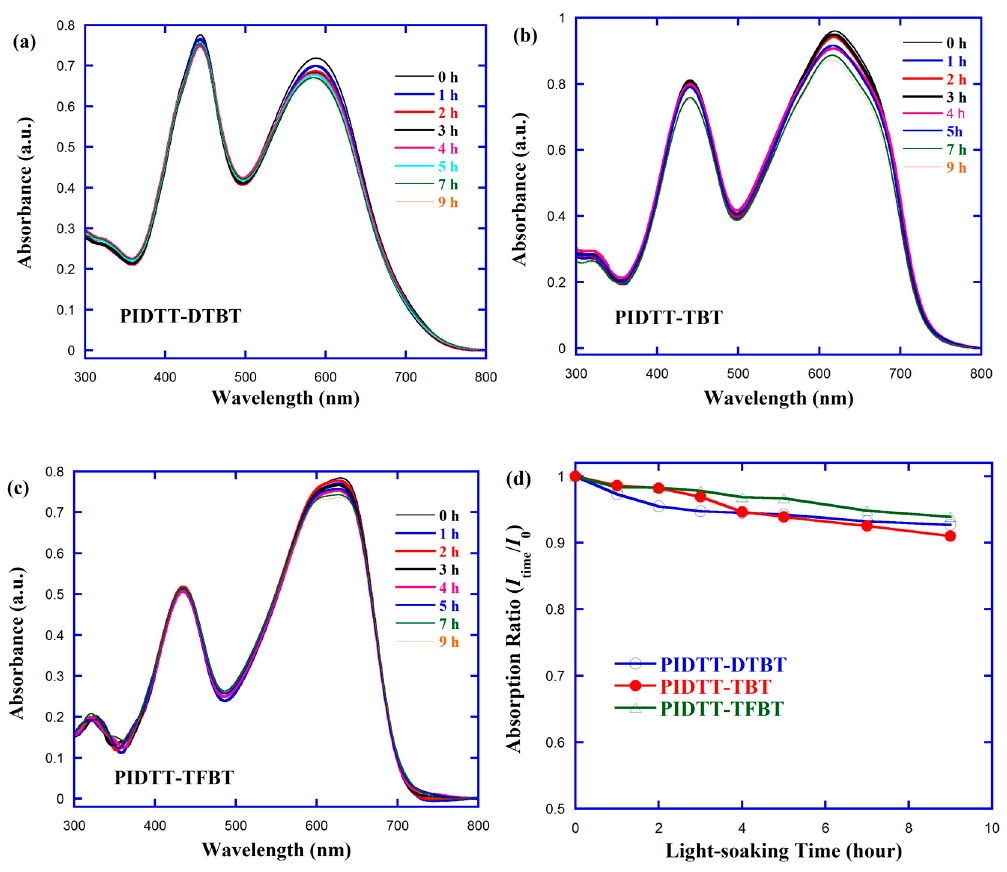
Figure 3. UV-vis absorption spectra variation after illumination of PIDTT-DTBT ( a ), PIDTT-TBT ( b ), and PIDTT-TFBT ( c ) films on ITO and a summary of light absorption intensity changes at the peak of each polymer as a function of light-soaking time ( d ).